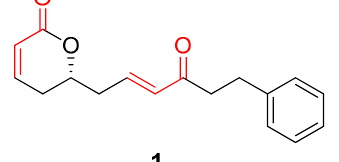
Figure 1. Rugulactone.